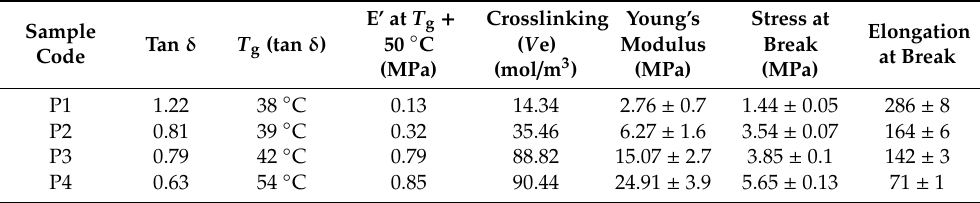
Figure 5. Dynamic mechanical analysis (DMA) of the four films: ( a ) Storage modulus and ( b ) loss factor (tan δ ) as a function of temperature of the four films.